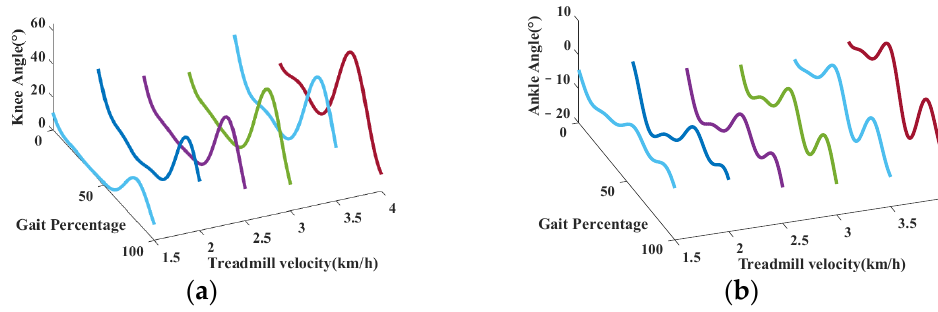
Figure 9. The desired angles of knee ( a ) and ankle ( b ) at different speeds.